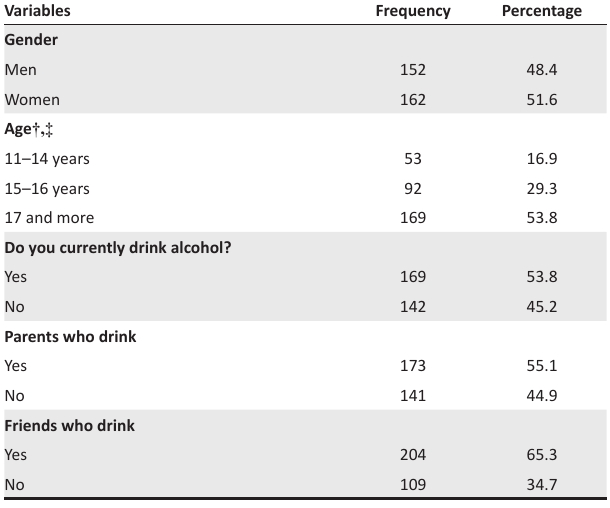
TABLE 1: Sociodemographic profile of learners ( N =